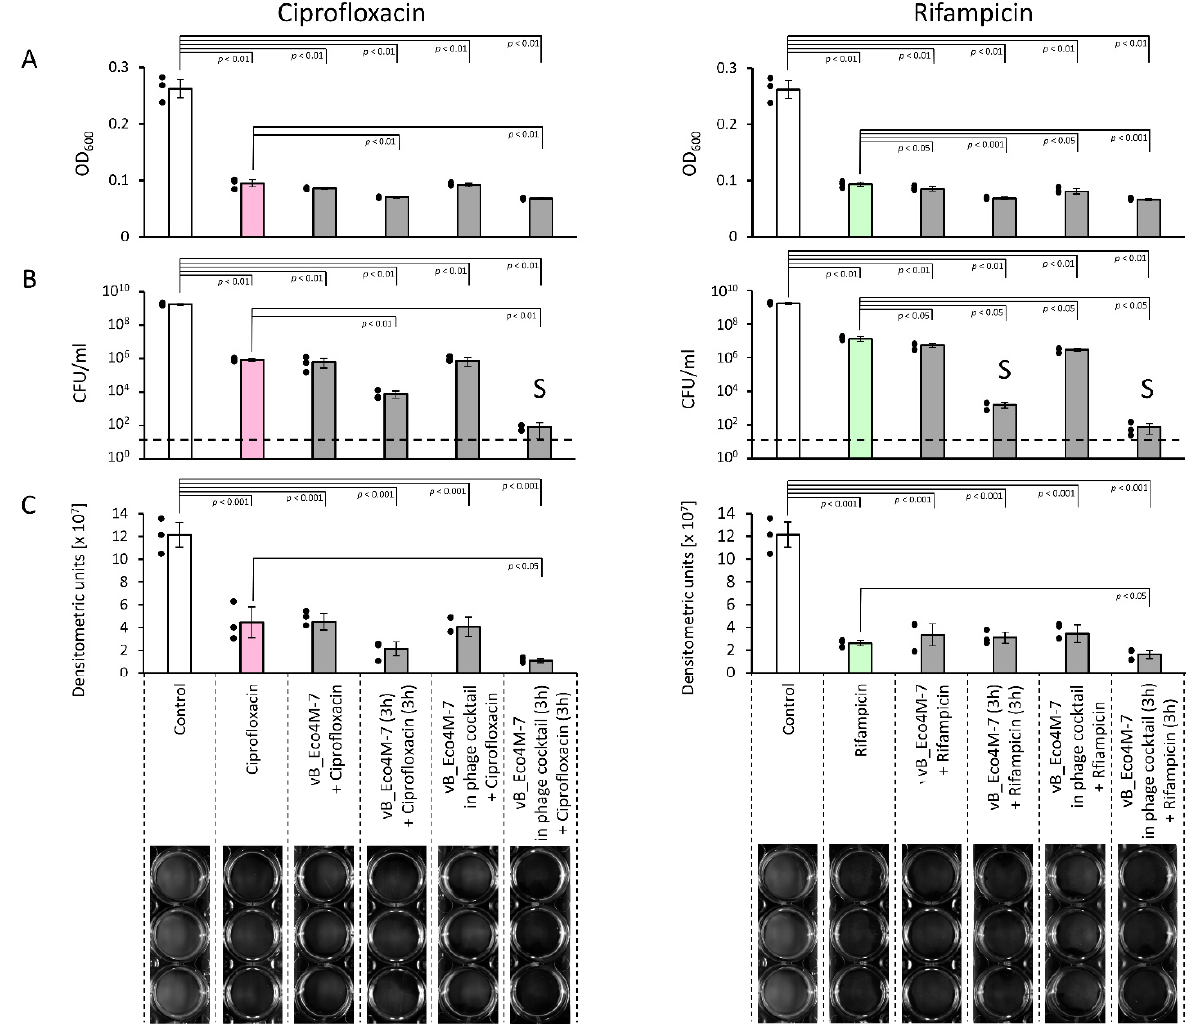
Figure 3. Bacterial biofilm density and viability of cells after a 6-h treatment with different antimicrobial agents individually or in the following combinations: ciprofloxacin (500 × MIC) or rifampicin (400 × MIC); vB_Eco4M-7 phage (MOI of 100) mixed with ciprofloxacin (500 × MIC) or rifampicin (400 × MIC); vB_Eco4M-7 phage (MOI of 100) replaced after a 3-h incubation with ciprofloxacin (500 × MIC) or rifampicin (400 × MIC); the phage cocktail (MOI of 100) mixed with ciprofloxacin (500 × MIC) or rifampicin (400 × MIC); the phage cocktail (MOI of 100) replaced after a 3-h incu- bation with ciprofloxacin (500 × MIC) or rifampicin (400 × MIC). The results were estimated by measuring the optical density at a wavelength of 600 nm ( A ), enumerating the number of survivors per ml of the suspension (CFU/mL) ( B ), or quantified densitometrically using UVITEC Allience Q9 Mini software ( C ). Signatures of the X-axis are the same for all panels and are placed at the bottom of the figure for clarity. “S” indicates synergistic interaction of tested agents ( B ). The black dashed lines represent the lower limit of detection ( B ). The results are presented as the mean values ± SD from three independent experiments. The black dots next to the columns denote datapoints from individ- ual experiments. Statistical analyses were performed using the one-way ANOVA ( p value < 0.05 was considered statistically